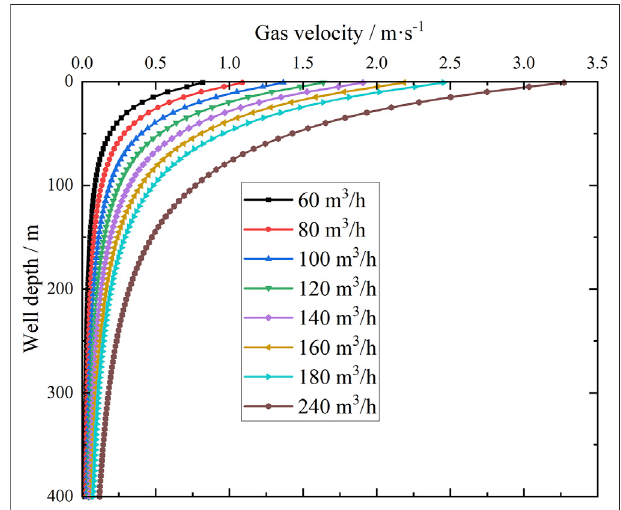
FIGURE 8 | Effect of gas injection displacement on pressure in return pipeline.